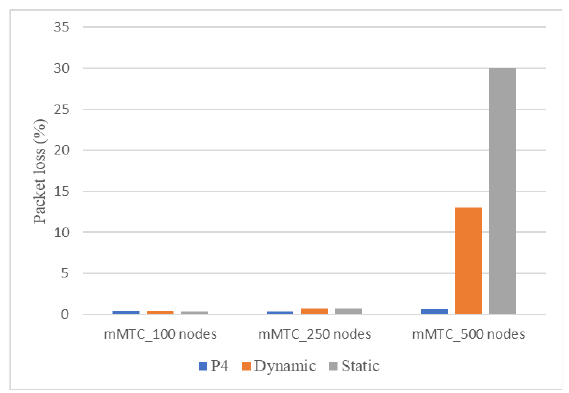
Figure 16. Average packet loss ratio per node in the mMTC slice.